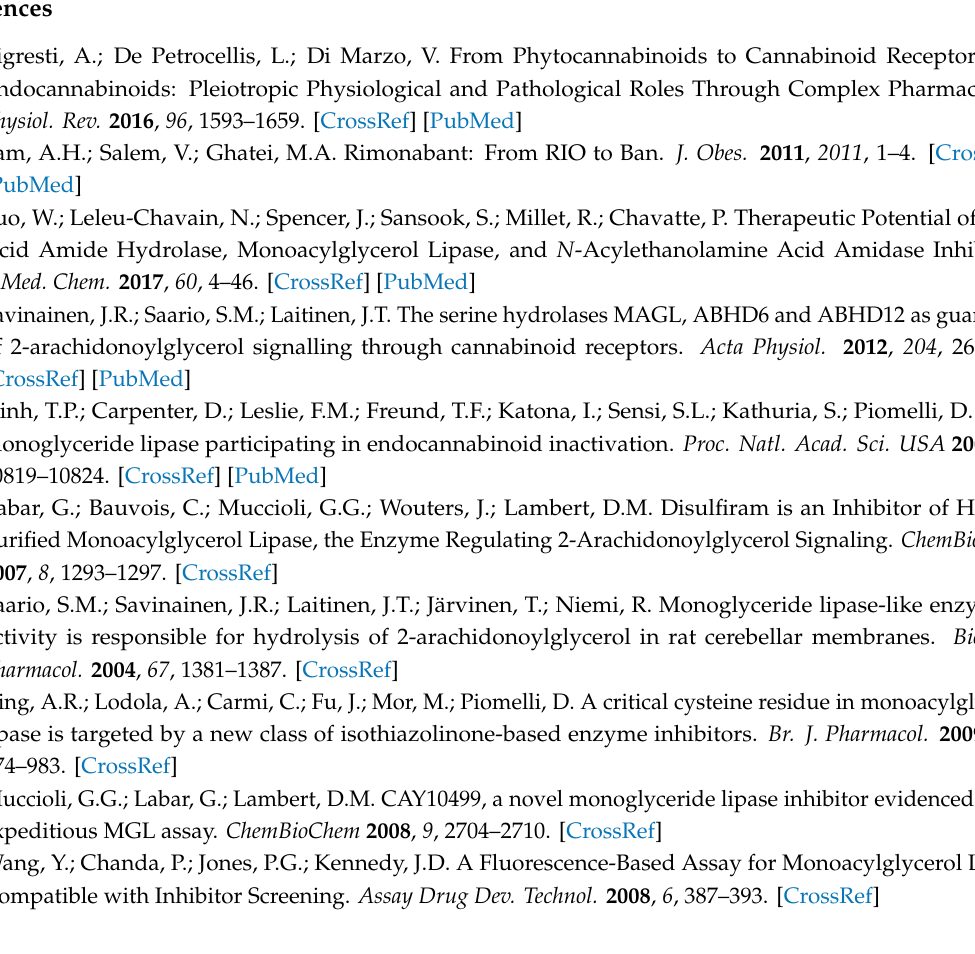
Supplementary Materials: The following are available online. Table S1. Mobile phases used for the separation of synthesis products. Table S2. Ligand: MAGL interactions. Table S3. Decay times and corresponding radius. Table S4. Assignment of 1 H and 13 C-NMR Chemical Shift in CDCl 3 . Figure S1. Comparison between spontaneous hydrolysis of 1a – d , 1f , and 1h – k . Figure S2: Time correlation functions for the scattered intensity (at θ = 90 ◦ ). Figure S3. Binding poses of tested compounds into the MAGL binding site. 1 H- and 13 C-NMR spectra of compounds 1a – k . Figure S4. MAGL complexes with compounds 1b and